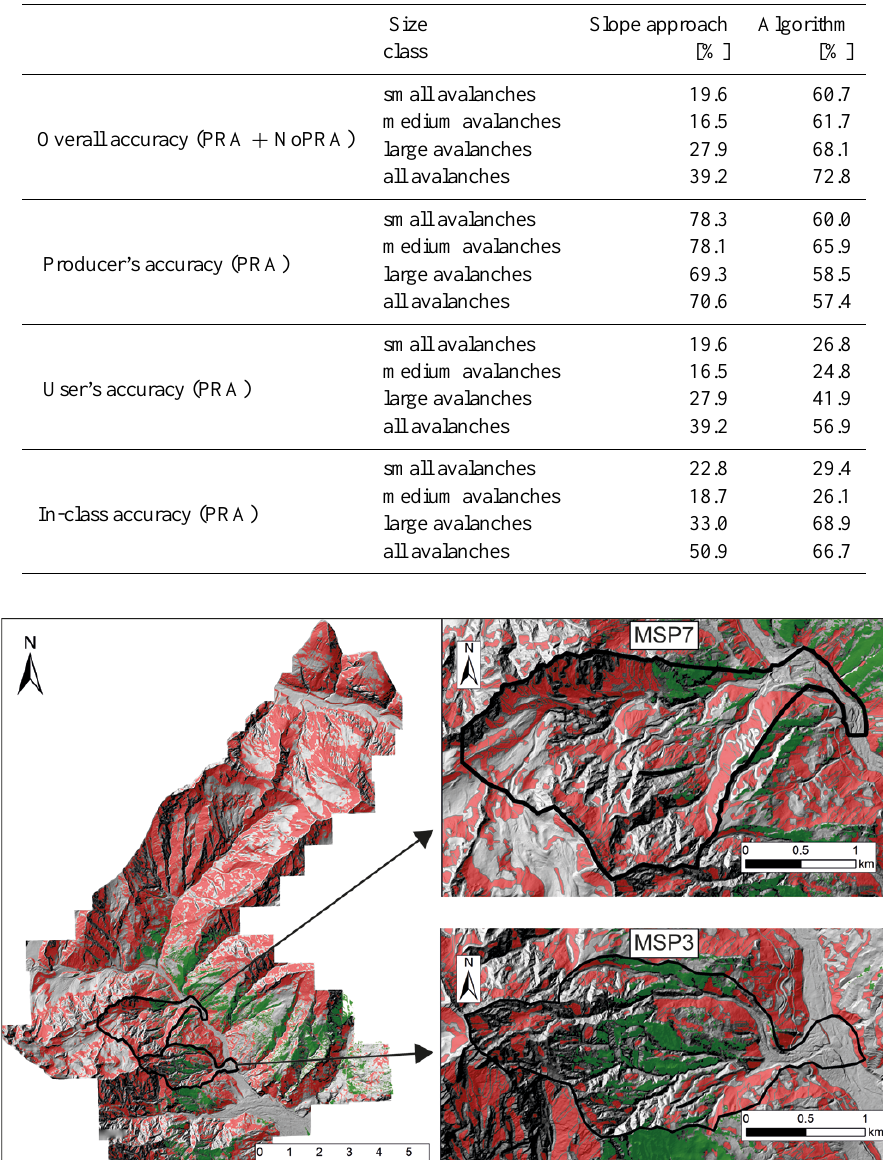
Table 3. Accuracy assessment of the algorithm and comparison with potential release areas defined only by slope angles between 28 ◦ and 50 ◦ .